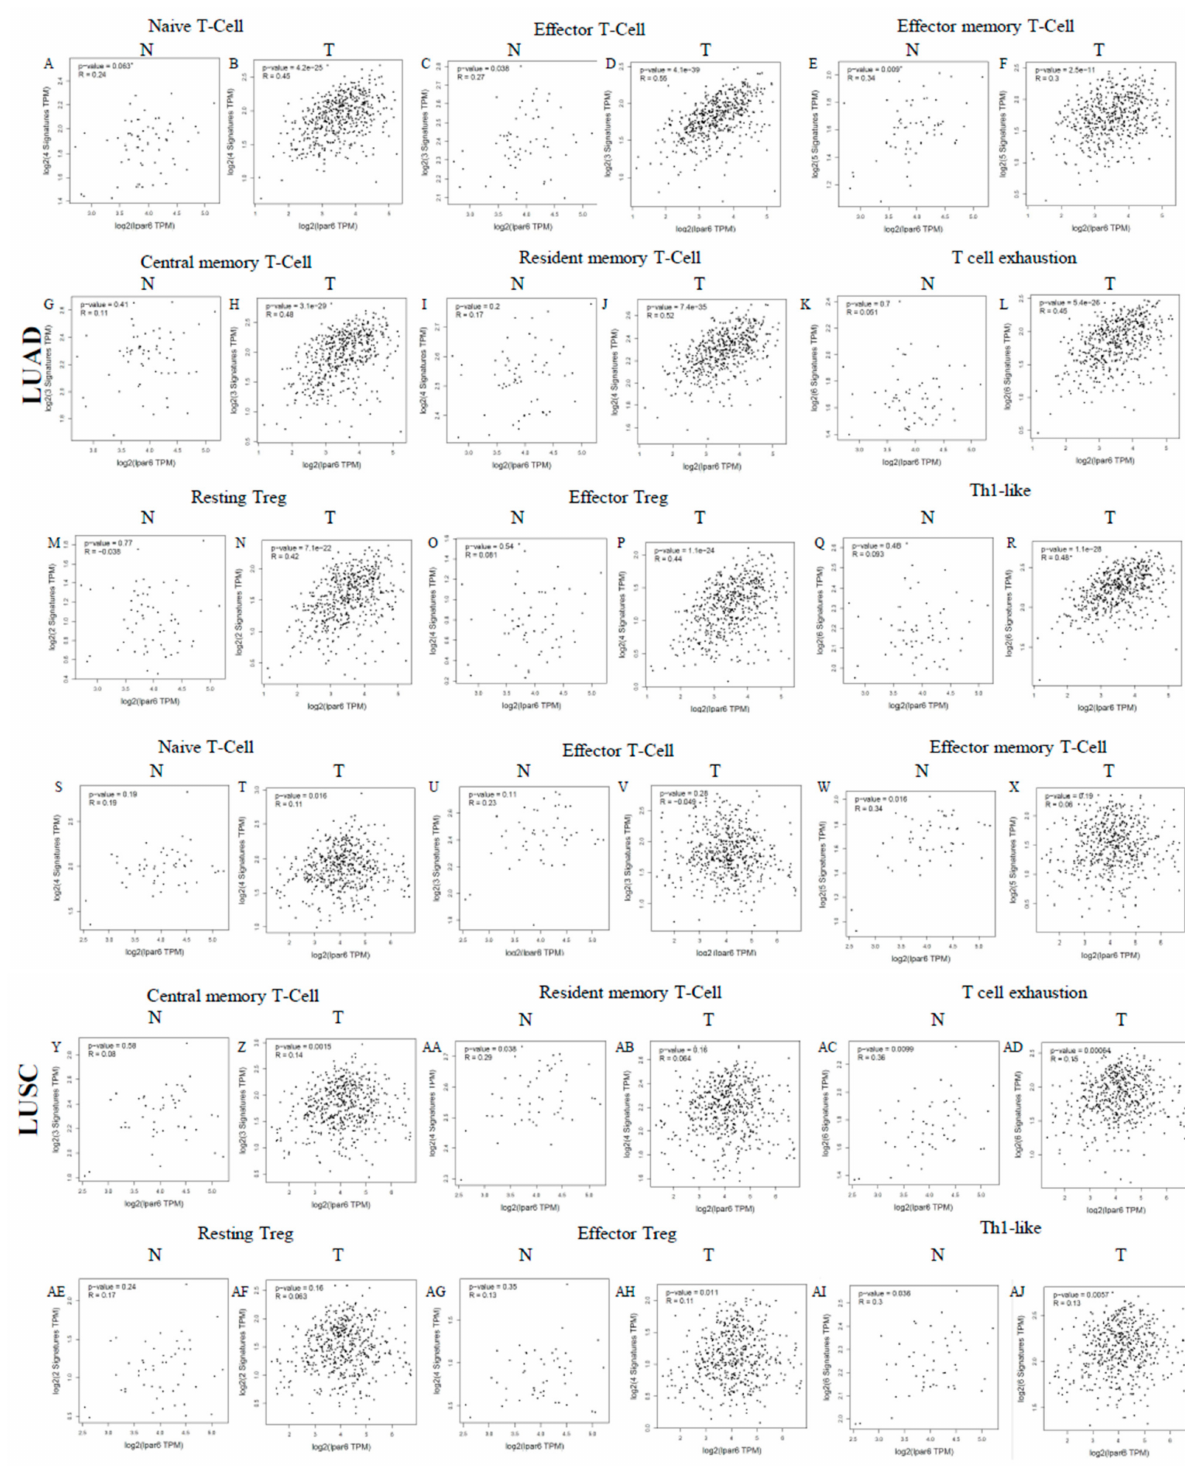
Figure 8. Correlation analysis between LPAR6 expression and various immune cells in normal and tumor tissue of LUAD and LUSC. ( A – R ) Scatterplots of correlations between LPAR6 expression and naive T-cell ( A , B ), effector T-cell ( C , D ), effector memory T-cell ( E , F ), central memory T-cell ( G , H ), resident memory T-cell ( I , J ), T cell exhaustion ( K , L ), resting Treg ( M , N ), effector Treg ( O , P ), Th1-like ( Q , R ) in the normal and tissue of LUAD; ( S – AJ ) Scatterplots of correlations between LPAR6 expression and gene markers of naive T-cell ( S , T ), effector T-cell ( U , V ), effector memory T-cell ( W , X ), central memory T-cell ( Y , Z ), resident memory T-cell ( AA , AB ), T cell exhaustion ( AC , AD ), resting Treg ( AE , AF ), effector Treg ( AG , AH ), Th1-like ( AI , AJ ) in